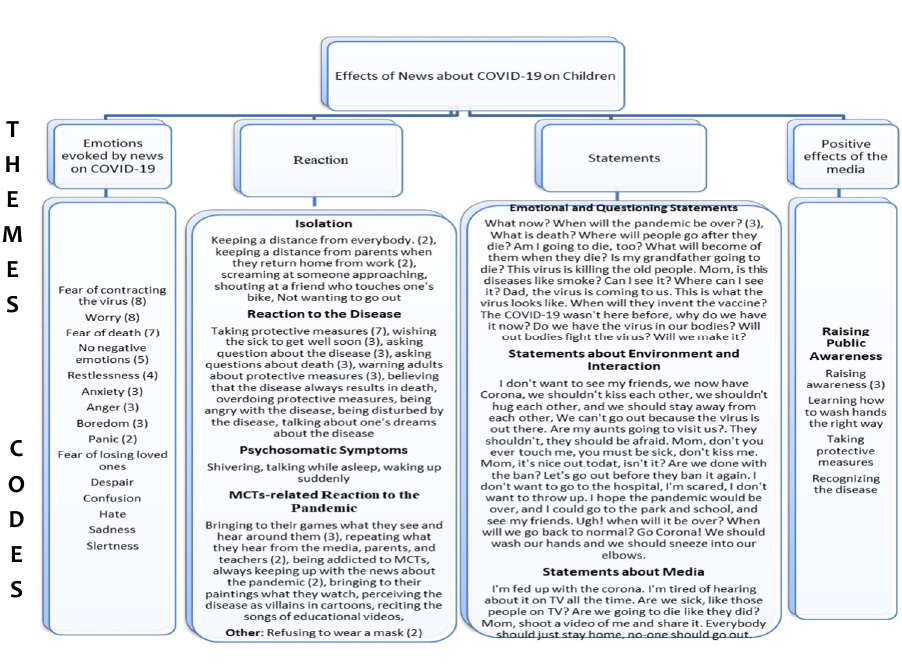
Figure 3: Effects of MCTs on Children